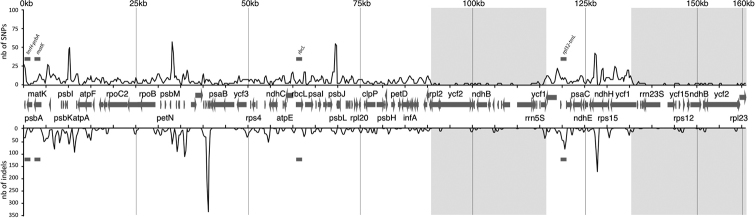
Sliding window analysis of the whole plastomes of five oak species. (window length: 500 bp, step size: 250 bp). X-axis: position of the mid-point of the window, Y-axis: number of SNPs (solid line) and indels (dashed line) positions of each window in bp. Coding regions and directions of transcription are indicated by arrows, inverted repeats by grey areas. Putative barcode loci are highlighted for SNPs and indels. For readability, only a few major genes are indicated.